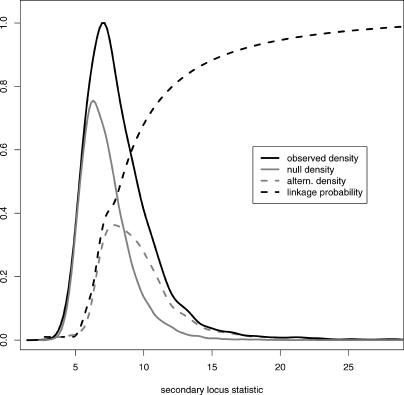
An Example of the Locus-Specific Linkage Probability Estimation Applied to the Secondary LociThe estimated density of the observed statistics is plotted (solid black). This density is modeled as a weighted mixture of probability densities corresponding to the “null” unlinked secondary loci (solid grey) and the “alternative” linked secondary loci (dashed grey). The estimated posterior probability of linkage is also shown (dashed black).